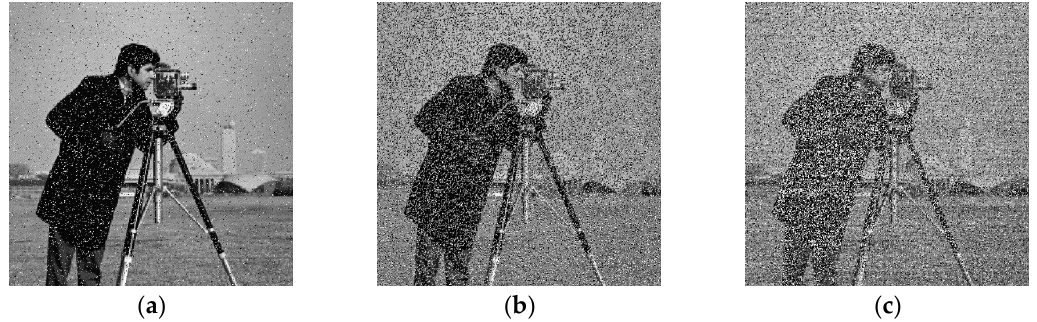
Figure 8. The decrypted results of the encrypted image with different strength noise: ( a ) k = 0.05, ( b ) k = 0.07, (c) k = 0.10.